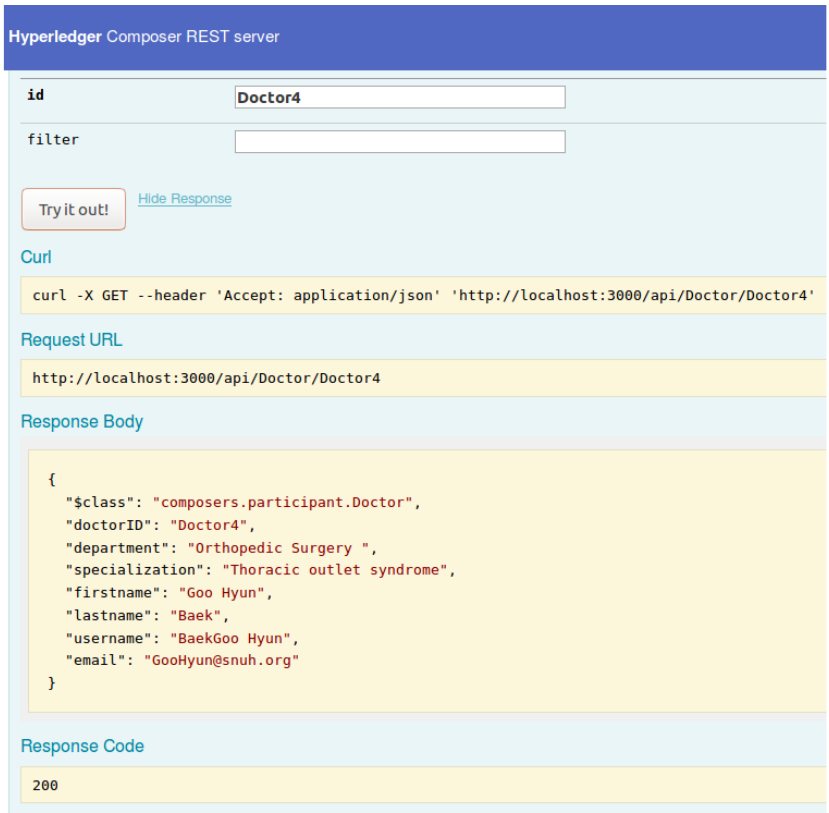
Figure 17. Fetching doctor record through the Composer REST server.